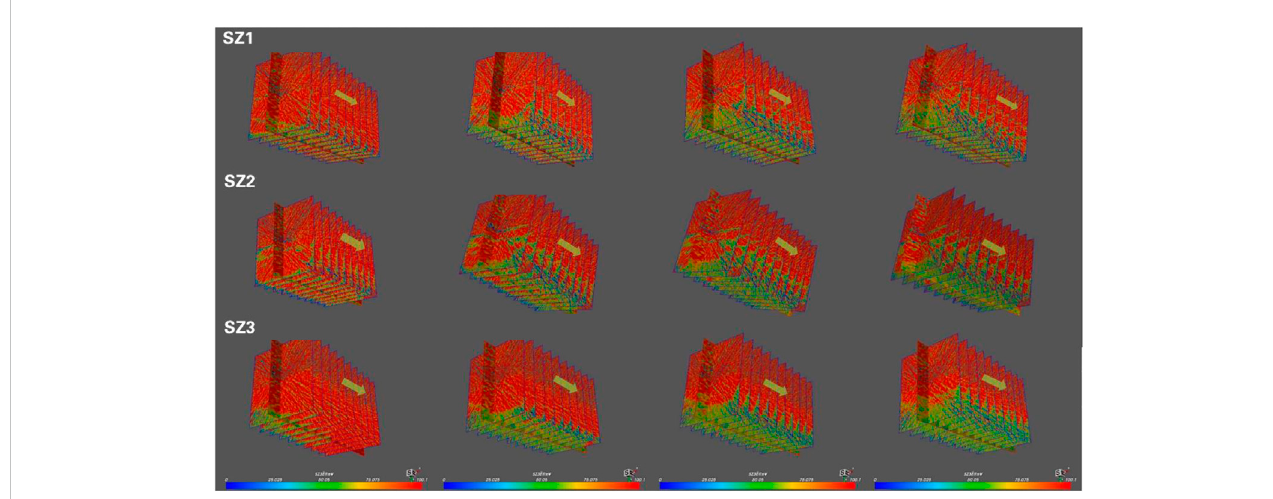
FIGURE 8 Oil saturation distribution of three groups of positive rhythm models (3D).